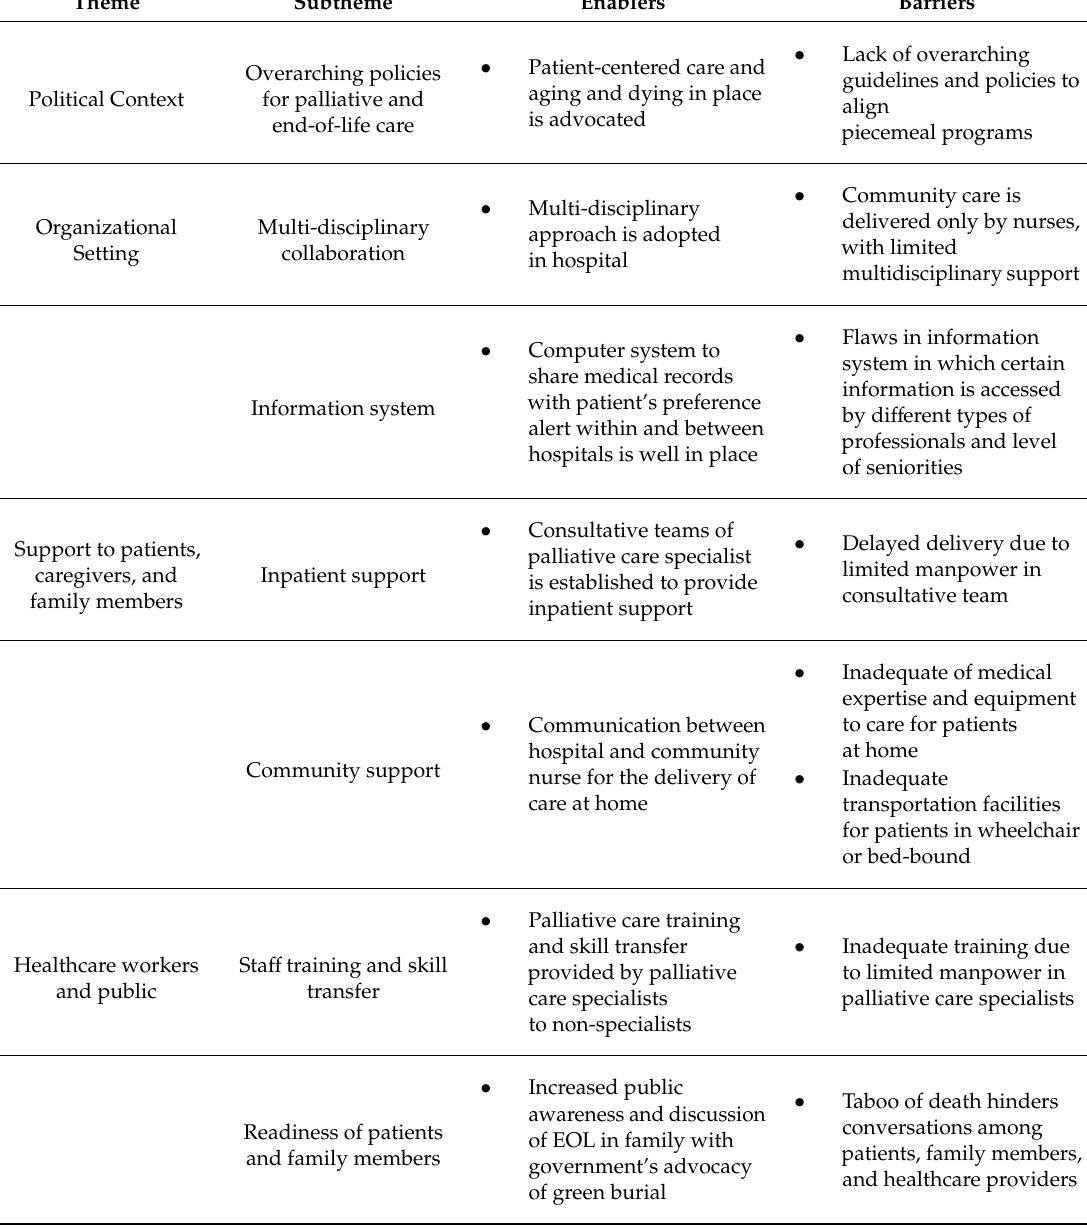
Table 2. Enablers and barriers in the implementation of palliative and end-of-life